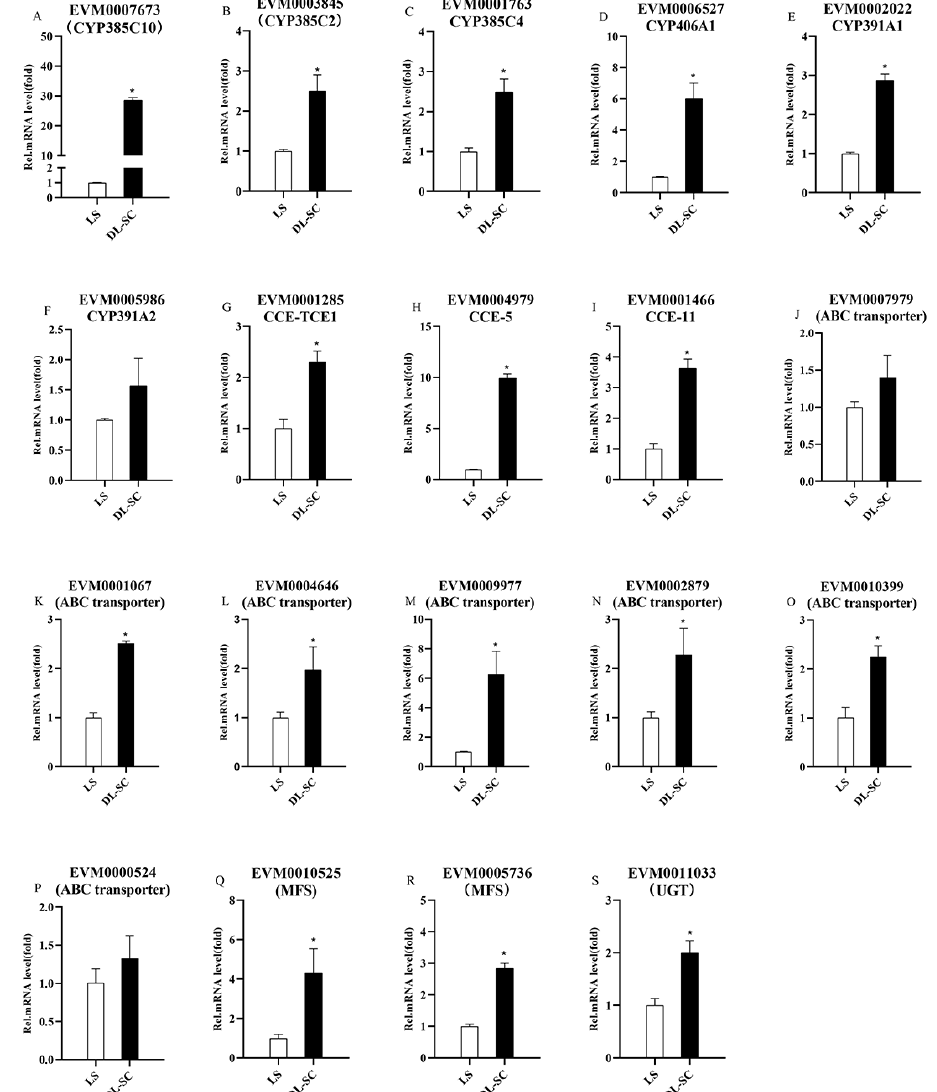
Figure 3. Overexpressed metabolism-related genes’ relative expression between the LS and DL-SC strains. ( A – F ) Relative expression of the P450 genes; ( G – I ) Relative expression of the CCE genes; ( J – P ) Relative expression of the ABC transporters; ( Q – R ) Relative expression of the major facilitators; ( S ) Relative expression of the UGT gene. The expression levels were normalized to that of LS. Error bars represent the standard deviation of the calculated mean based on three biological replicates. In each panel, means with asterisks indicate significantly different ( t -test, p > 0.05).